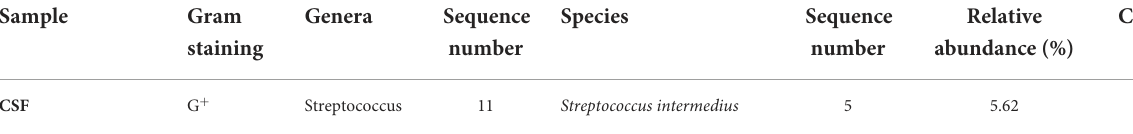
TABLE 2 List of macro genomic pathogens detected in cerebrospinal fluid (CSF) samples at 4 weeks after